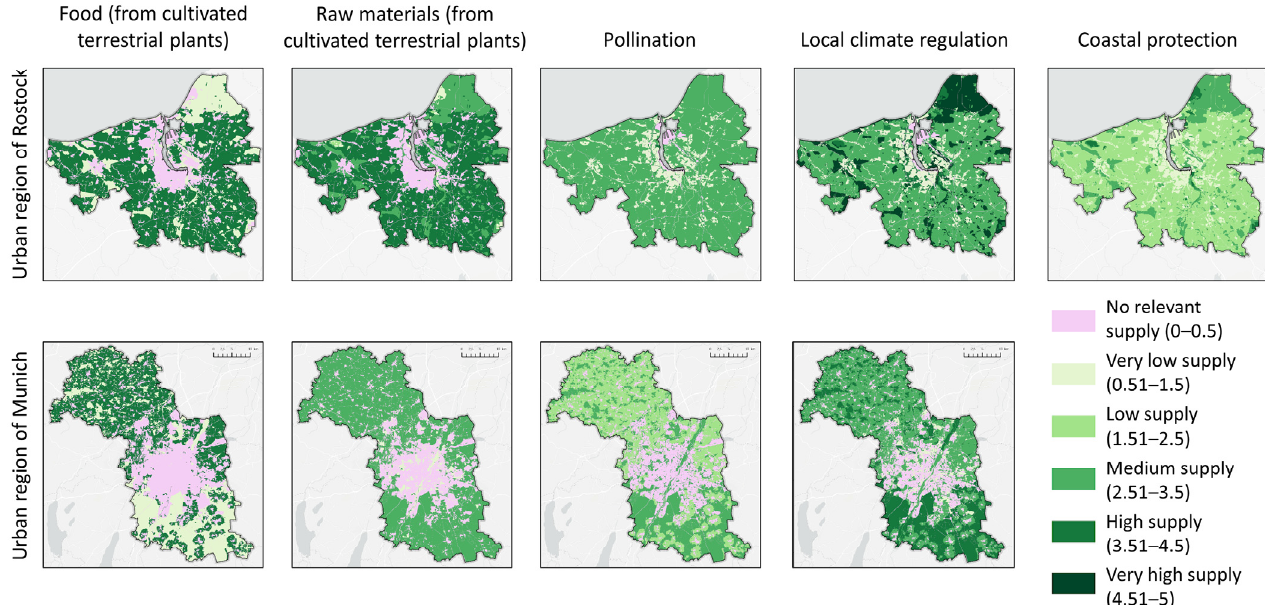
Figure 2. ES supply of food (from cultivated terrestrial plants), raw materials (from cultivated terrestrial plants), pollination, local climate regulation, and coastal protection. The expert estimates ranged from no relevant supply (0) to very high supply (5). The highest ES supply (5) is shown in dark green, and the lowest ES supply (0) is in pink. Based on data from Urban Atlas [44]. Larger maps are provided in Supplementary Materials S2.